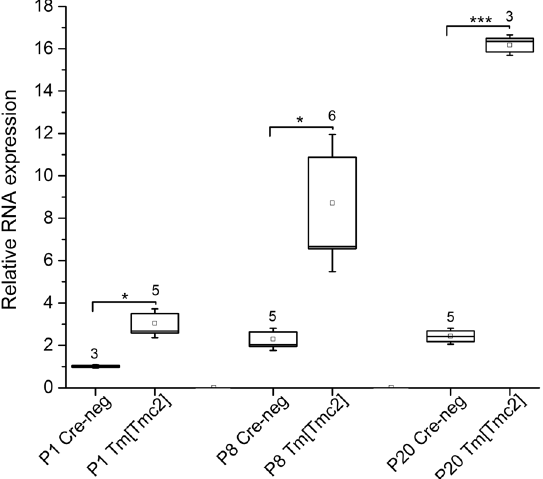
Figure 2. Relative expression of GFP in Rosa26 tm ( CAG-LSL-Tmc2-IRES-GFP ) mice . Total RNA was prepared from single cochlea harvested from Rosa26 tm ( CAG-LSL-Tmc2-IRES-GFP )] ;Tmc1 Δ / Δ Tmc2 Δ / + positive for Gfi1 cre ( Tm [ Tmc2 ]) or negative for Gfi1 cre ( Cre-neg ) at P1, P8 and P20. Quantitative RT-PCR was performed with β -actin and GFP primers in triplicate (see methods) and repeated from biological replicates (number of samples are noted above the box plots). Due to bicistronic expression of Tm [ Tmc2 ] and GFP in Rosa26 tm (